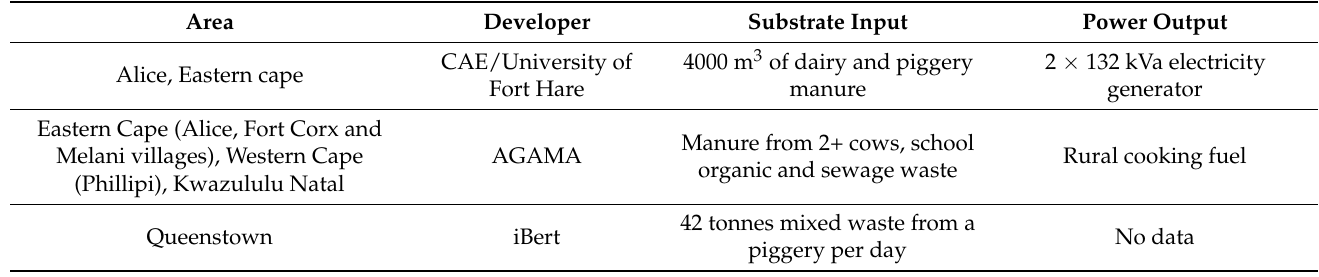
Table 4. Biogas digesters in the Eastern